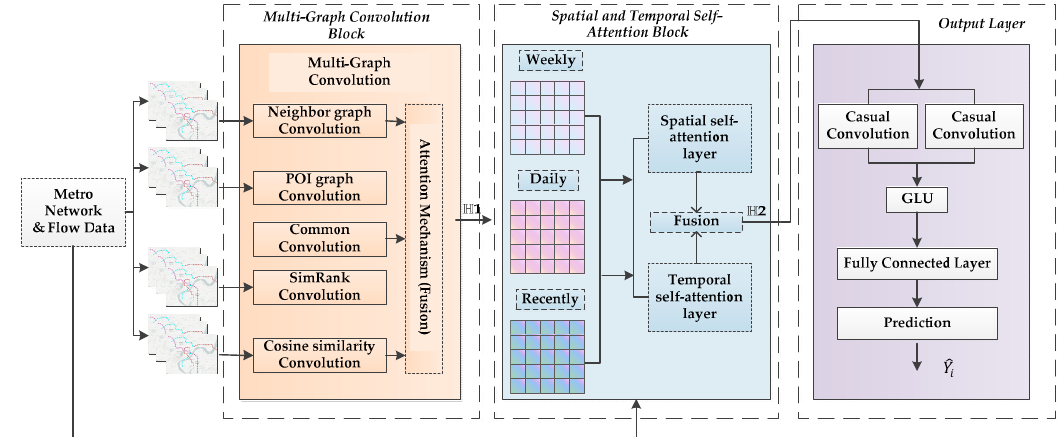
Figure 3. Framework of Model.